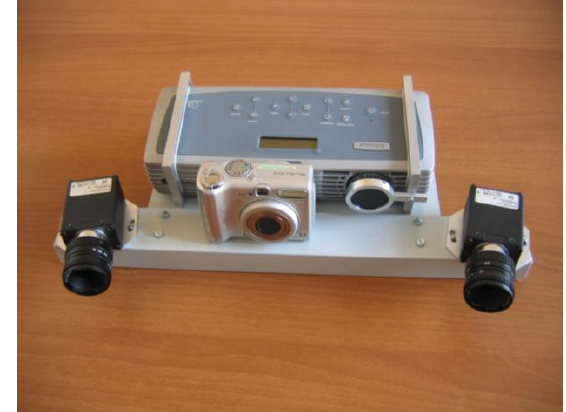
Figure 1. Photogrammetric system